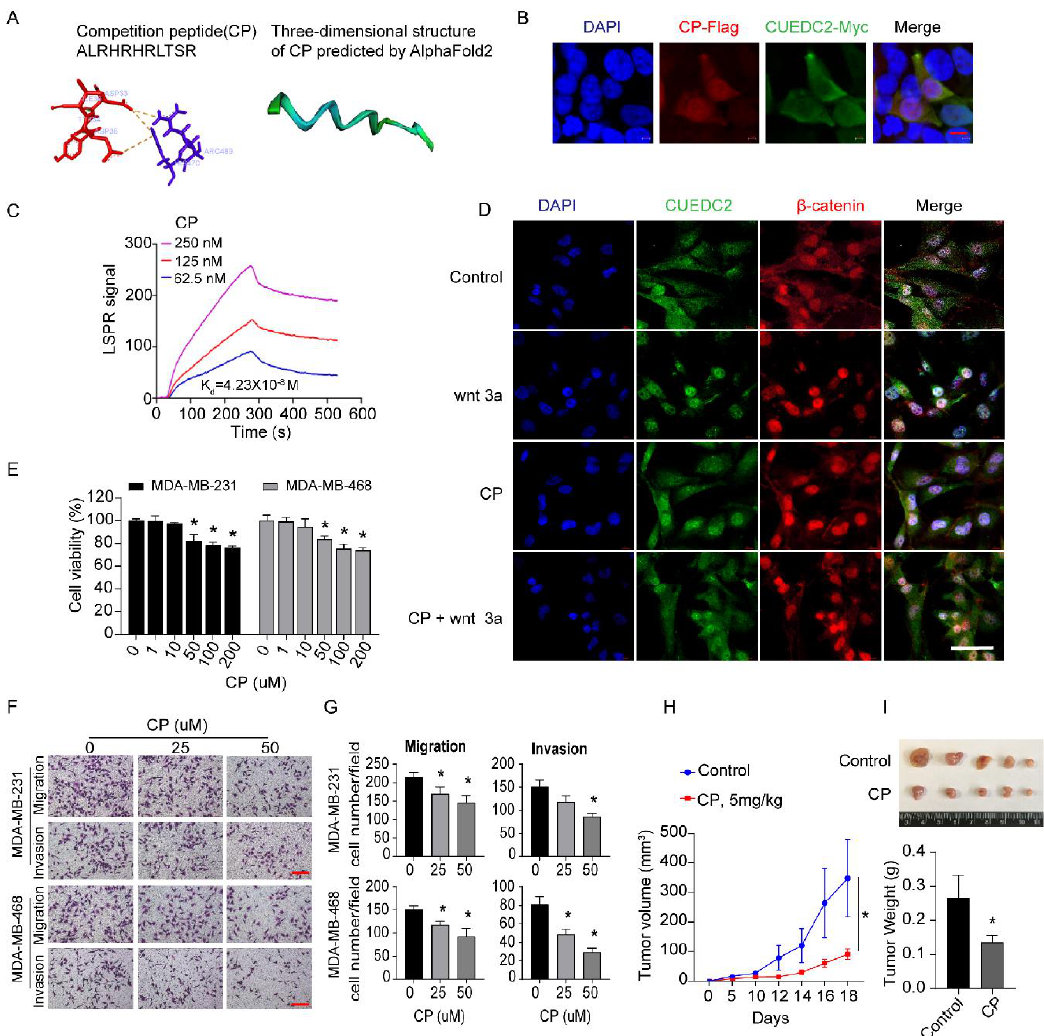
Figure 5. Interrupting CUEDC2- β -catenin interaction with competition peptides (CP) prevents malignant behaviors of TNBC in vitro and in vivo. ( A ) The amino acid sequence of CP and the predicted mode of combination between CP and CUEDC2 by AlphaFold2. ( B ) Co-localization of CP and CUEDC2 in HEK-293 FT cells. Bar = 10 µ m. ( C ) LSPR analysis of the binding affinity of CP